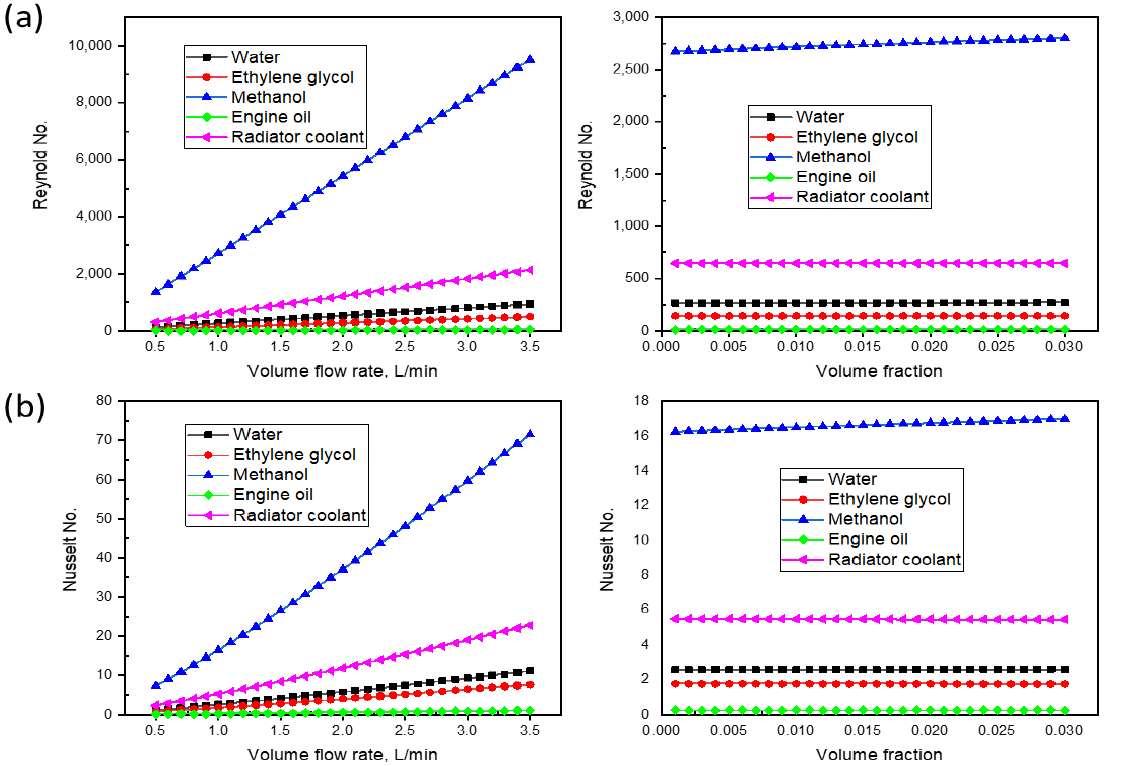
Figure 6. Effect of volume flow rate and volume fraction on ( a ) Reynolds and ( b ) Nusselt numbers.